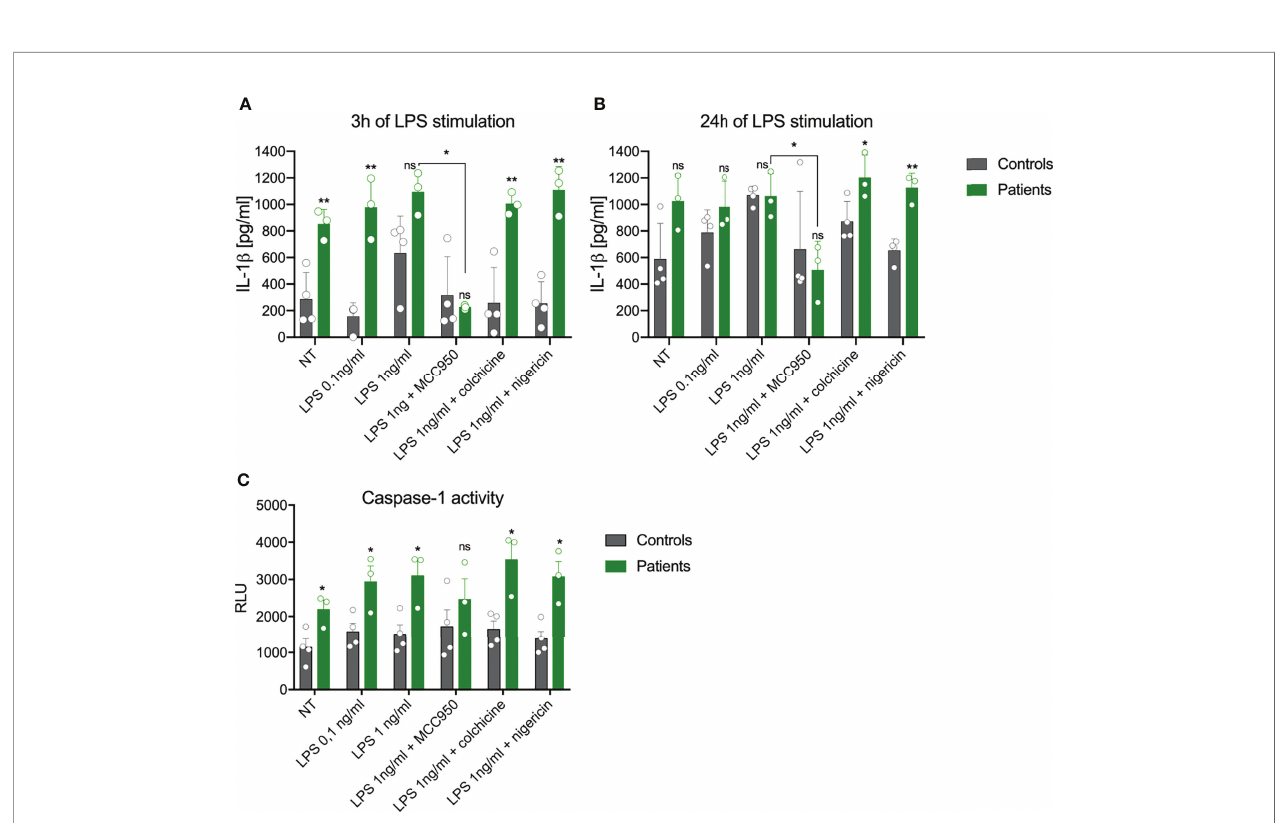
FIGURE 3 | Impact of NLRP3 mutation on in fl ammasome activation in peripheral blood mononuclear cells (PBMCs). The capacity of PBMCs from healthy controls (grey) and patients (green) to secrete IL-1 b after stimulation with LPS or LPS+nigericin was analyzed after (A) 3 h or (B) 24 h The speci fi c NLPR3 inhibitor MCC950, but not the microtubule inhibitor colchicine, was able to inhibit IL-1 b release. (C) Activation of caspase-1 in PBMCs was evaluated after 24 h (mean ± SEM, results compared by t -test: * p < 0.05; ** p < 0.01). NT, not treated; ns, non signi fi